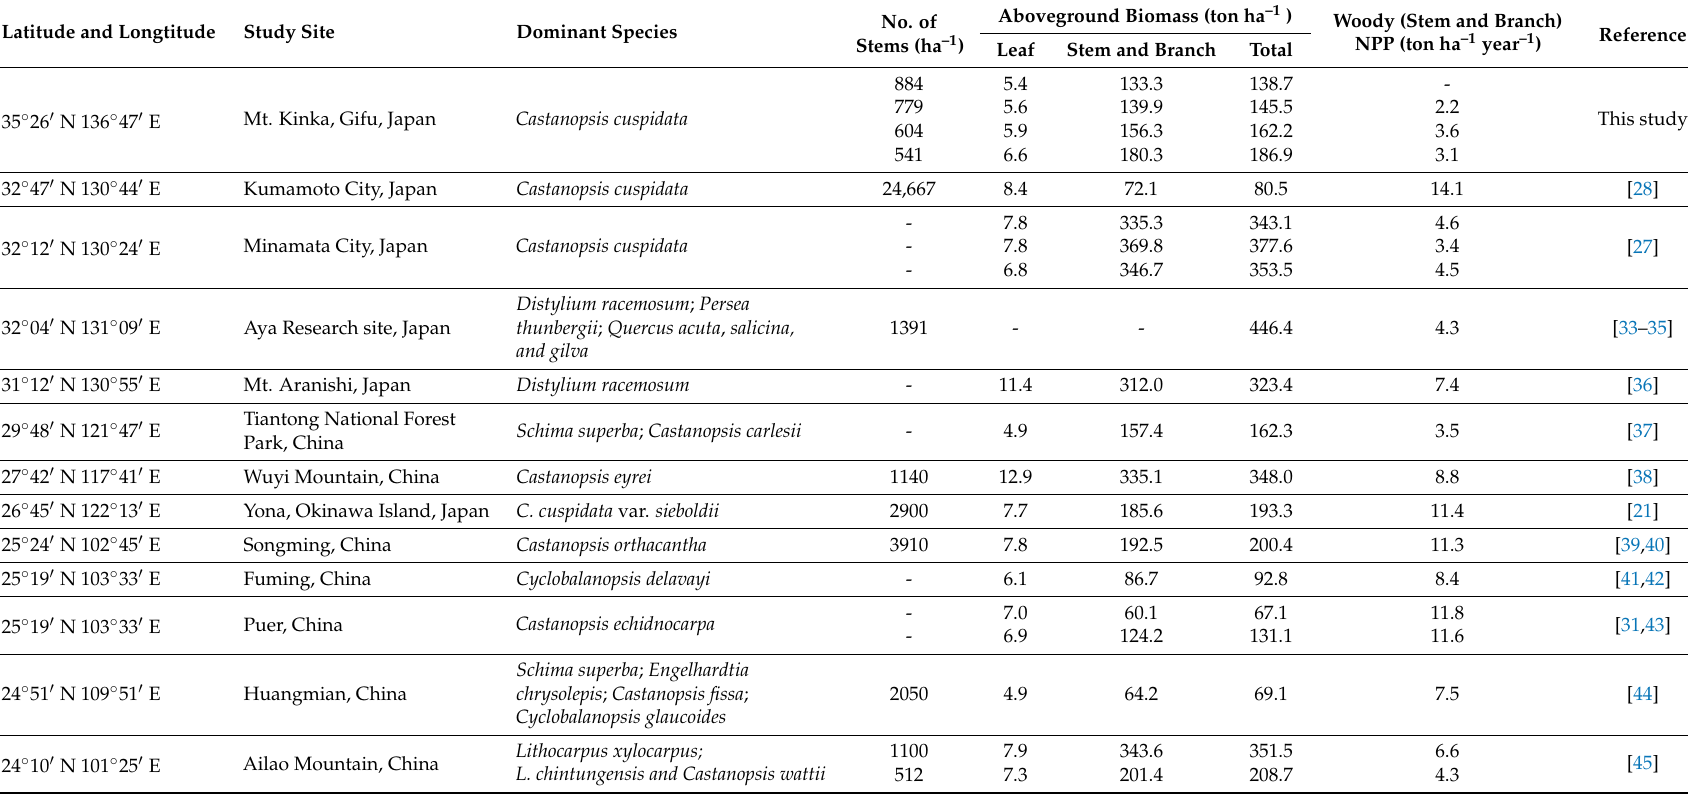
Table 6. Comparison of forest biomass and woody NPP of lucidophyllous (evergreen broad-leaved) forests in East Asia. NPP: Net primary production. Latitude and Longtitude Study